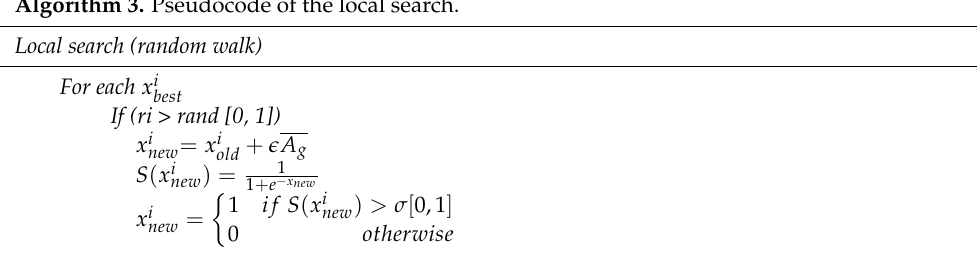
Algorithm 3. Pseudocode of the local